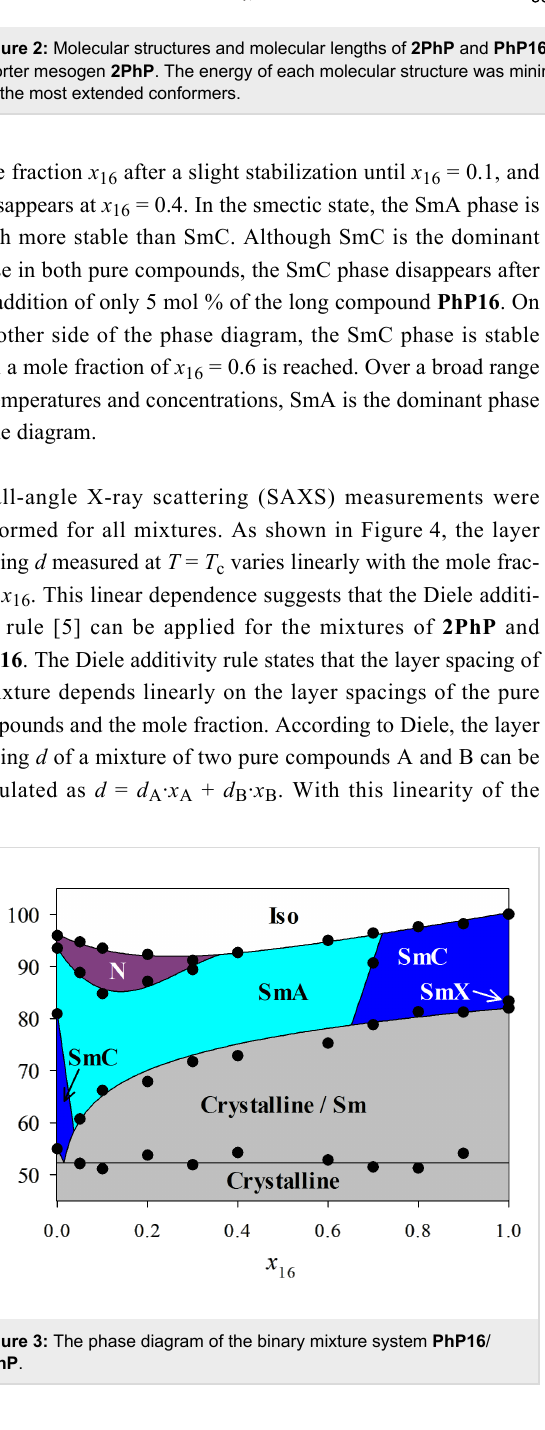
Figure 2: Molecular structures and molecular lengths of 2PhP and PhP16. The longer mesogen PhP16 is approximately twice the length of the shorter mesogen 2PhP . The energy of each molecular structure was minimized by molecular modelling with the semiempirical method MOPAC/AM1 for the most extended conformers.